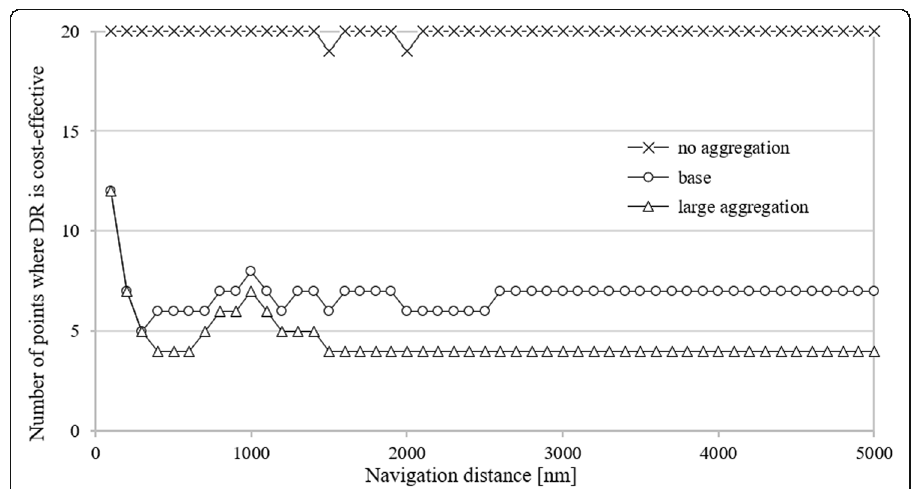
Fig. 5 Results of modifying the volume of cargo aggregated in transshipment